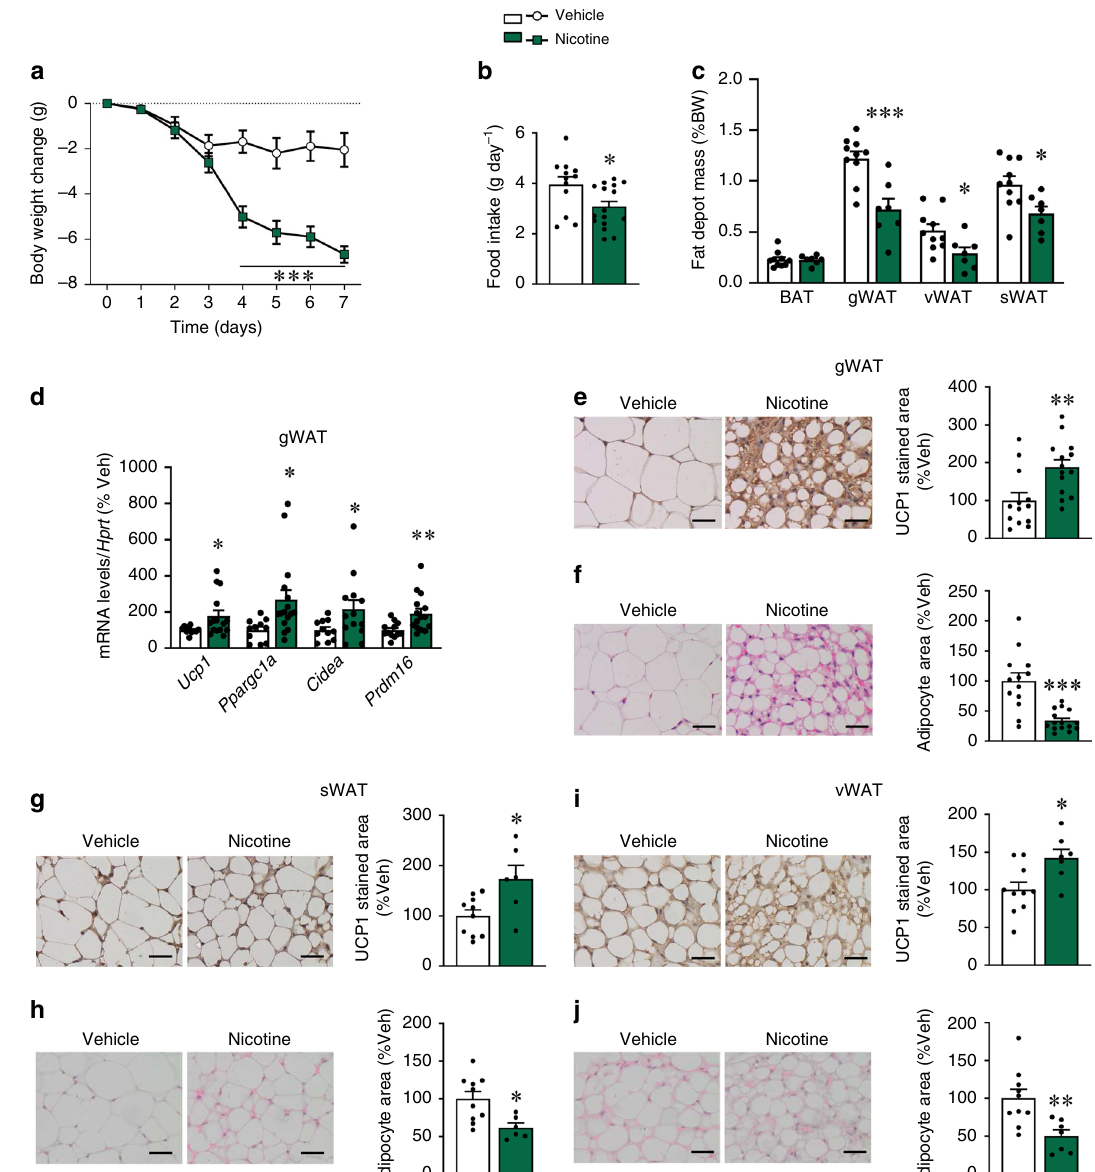
Fig. 1 Effect of central nicotine WAT browning. a Body weight change (vehicle n = 12, nicotine n = 16 mice). b Daily food intake (vehicle n = 12, nicotine n = 16 mice). c Fat depot mass (vehicle n = 10, nicotine n = 7 mice). d mRNA levels of thermogenic markers in the gWAT (vehicle n = 11, 11, 11, 12, nicotine n = 15, 16, 13, 15 mice). e UCP1 staining (left panel 40×, scale bar: 100 μ m) and UCP1 stained area (right panel) in gWAT (vehicle n = 13, nicotine n = 14 mice). f H&E staining (left panel 40×, scale bar: 100 μ m) and adipocyte area (right panel) in gWAT (vehicle n = 13, nicotine n = 15 mice). g UCP1 staining (left panel 40×, scale bar: 100 μ m) and UCP1 stained area (right panel) in sWAT (vehicle n = 10, nicotine n = 6 mice). h H&E staining (left panel 40×, scale bar: 100 μ m) and adipocyte area (right panel) in sWAT (vehicle n = 10, nicotine n = 6 mice). i UCP1 staining (left panel 40×, scale bar: 100 μ m) and UCP1 stained area (right panel) in vWAT (vehicle n = 10, nicotine n = 7 mice). j H&E staining (left panel 40×, scale bar: 100 μ m) and adipocyte area (right panel) in vWAT (vehicle n = 10, nicotine n = 7 mice) of mice ICV treated with vehicle or nicotine. Center values represent average; error bars represent SEM. Statistical signi fi cance was determined by two-sided t -Student; * P < 0.05, ** P < 0.01, *** P < 0.001 vs. vehicle. The experiments were repeated three times; the samples represent biological replicates. Source data are provided as a Source Data fi